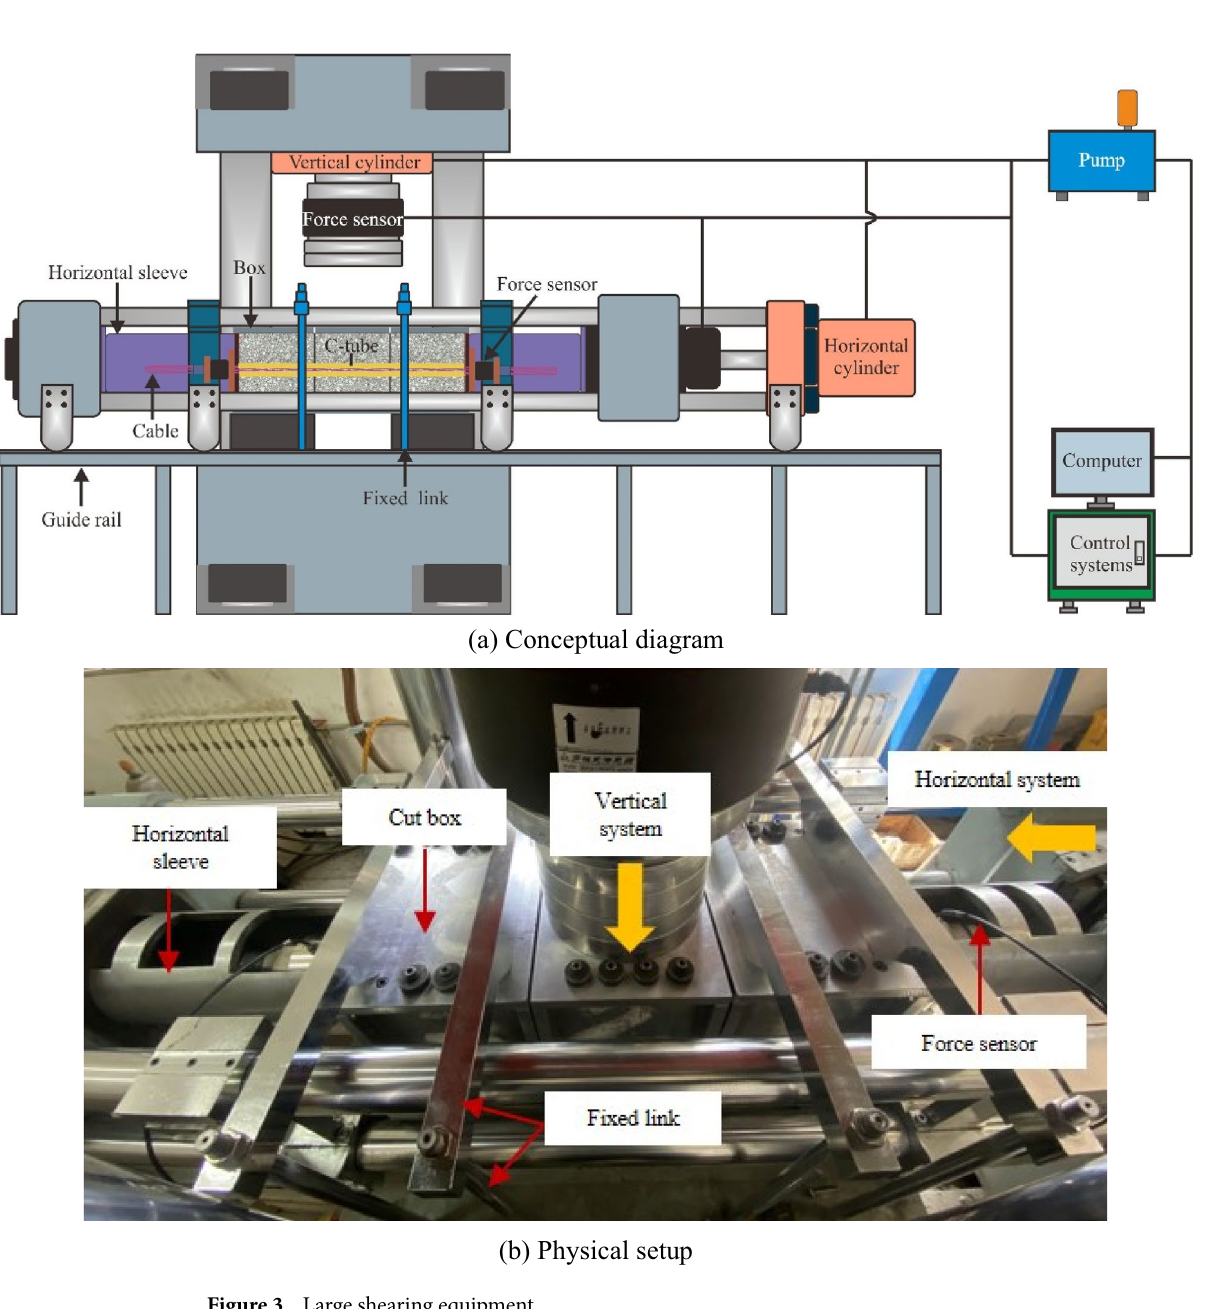
Figure 3. Large shearing